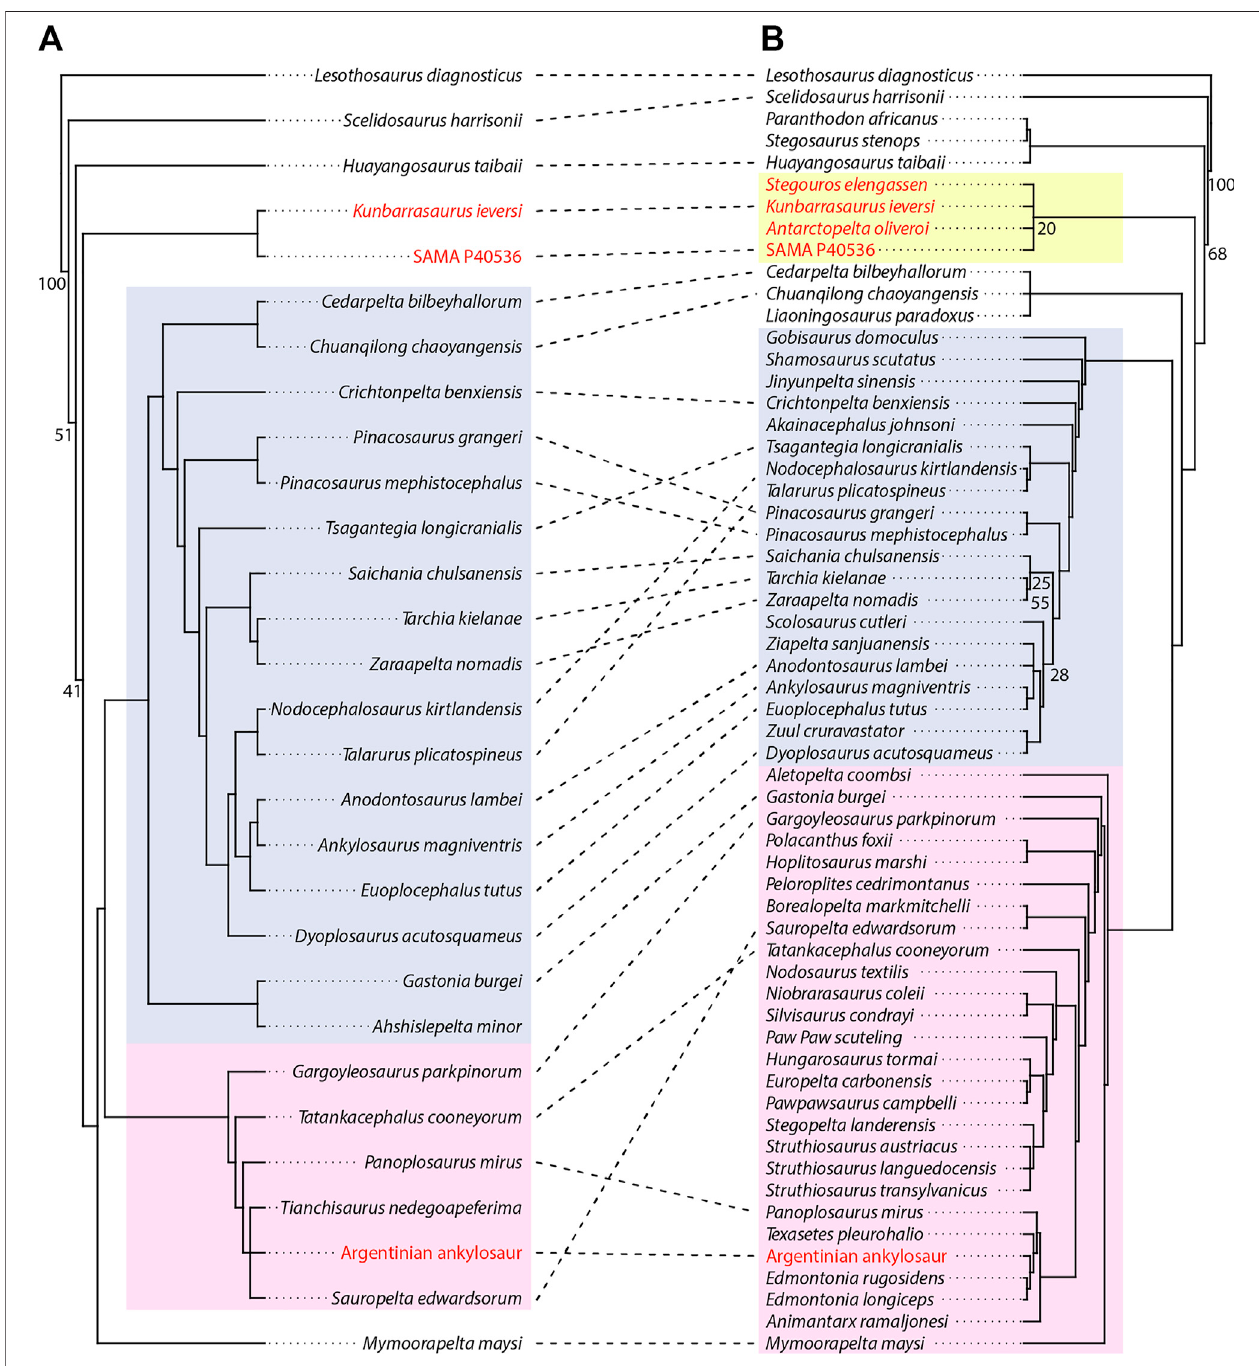
FIGURE 8 | Results of the phylogenetic analyses. (A) Reduced strict consensus of 1,630 MPTs of 423 steps (CI: 0.536, RI: 0.704, RC: 0.377) recovered after inclusionofSAMAP40536 intothecharacter-taxon matrix ofArbour and Currie (2016), (B) Reduced strictconsensus ofthe20MPTs of696steps (CI:0.359,RI:0.653, RC: 0.234) recovered after inclusion of SAMA P40536 into the character-taxon matrix of Soto-Acuña et al. (2021). Node labels indicate GC bootstrap support values above 20. Bootstrap values for all nodes are provided in Supplementary Material S3 (Figures S3.1 and S3.2) . All Gondwanan taxa are highlighted in red. The extent of Parankylosauria is highlighted in yellow, Ankylosauridae in blue, and Nodosauridae in pink.